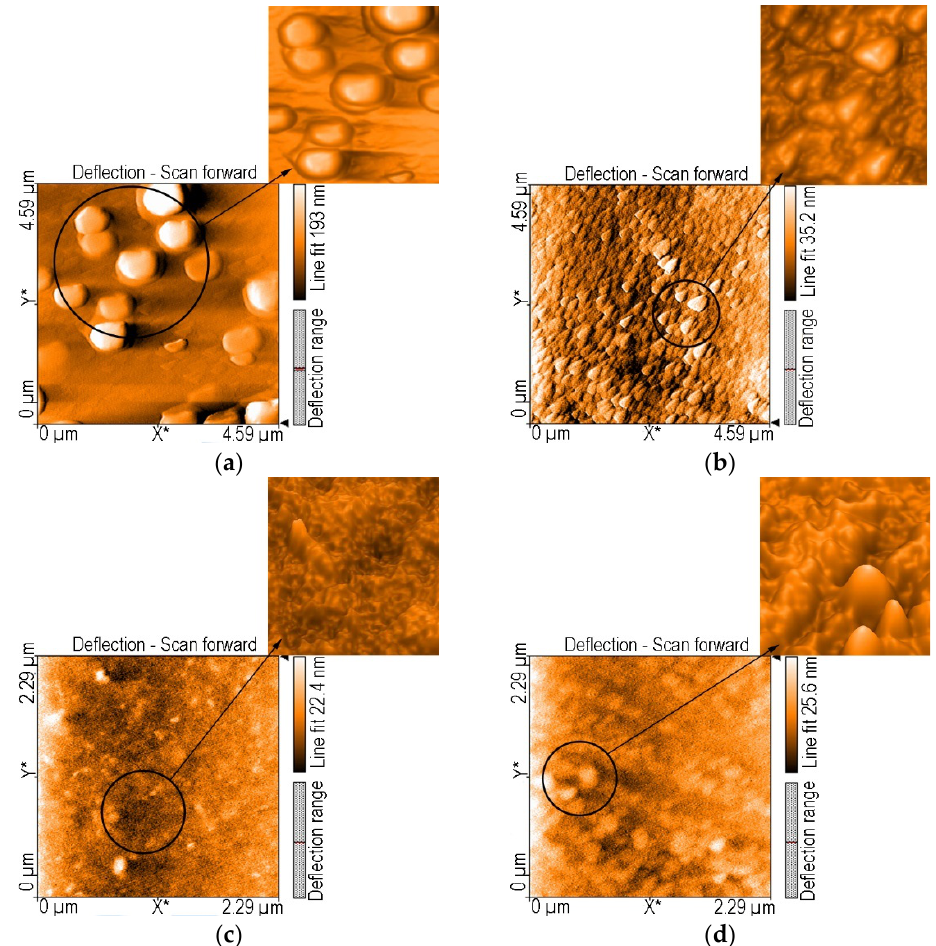
Figure 8. The 2D and 3D AFM images of (5-COOCH3-3MPP) deposited from THF ( a ); (5-COOH- 3MPP) deposited from THF ( b ); (5-COOH-3MPP)- k -carrageenan composite material deposited from DMF-water mixture ( c ); (5-COOH-3MPP)- k -carrageenan composite material after capturing CO 2 gas, in liquid DMF-water mixture ( d